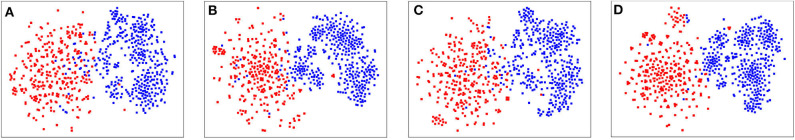
PCA analysis of instance bag embeddings. (A) Proto+MAX, (B) Proto+AVE, (C) Proto+PER, (D) AMProto.